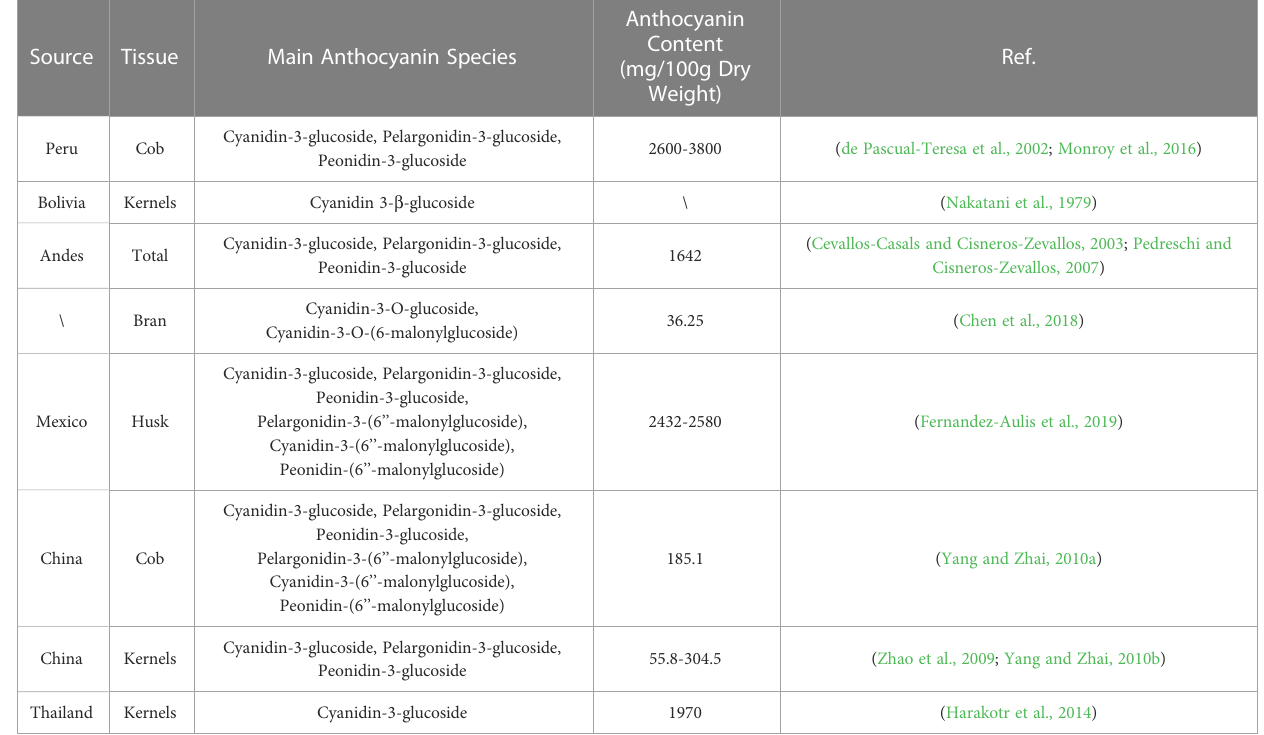
TABLE 1 Anthocyanin content in different tissues of different types of purple maize.